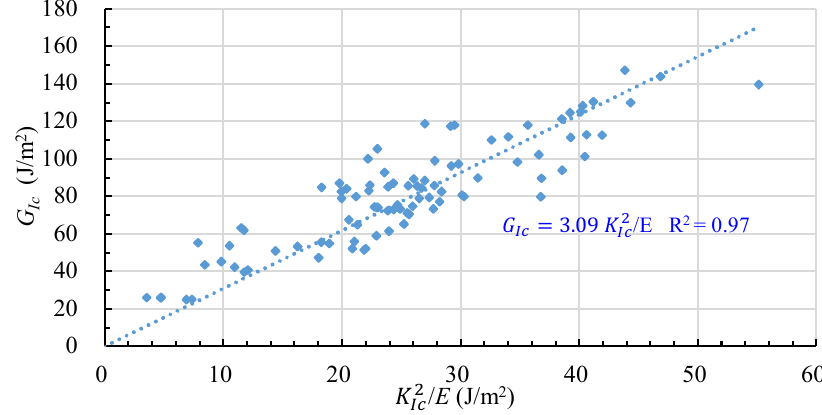
Figure 3. Relation between 𝐺 (cid:3010)(cid:2913) and 𝐾 (cid:3010)(cid:3030)(cid:2870) /E.